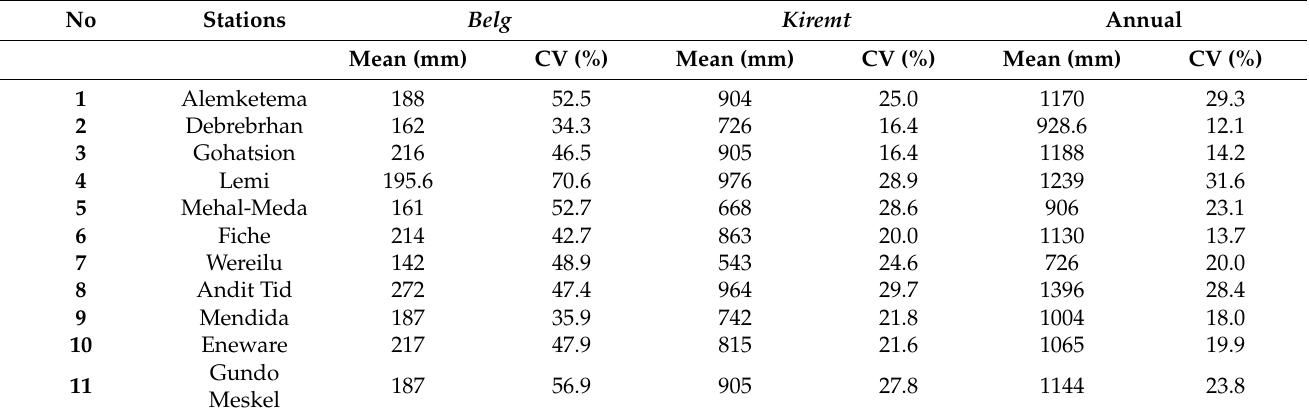
Table 1. Seasonal and Annual Precipitation Statistical Summary